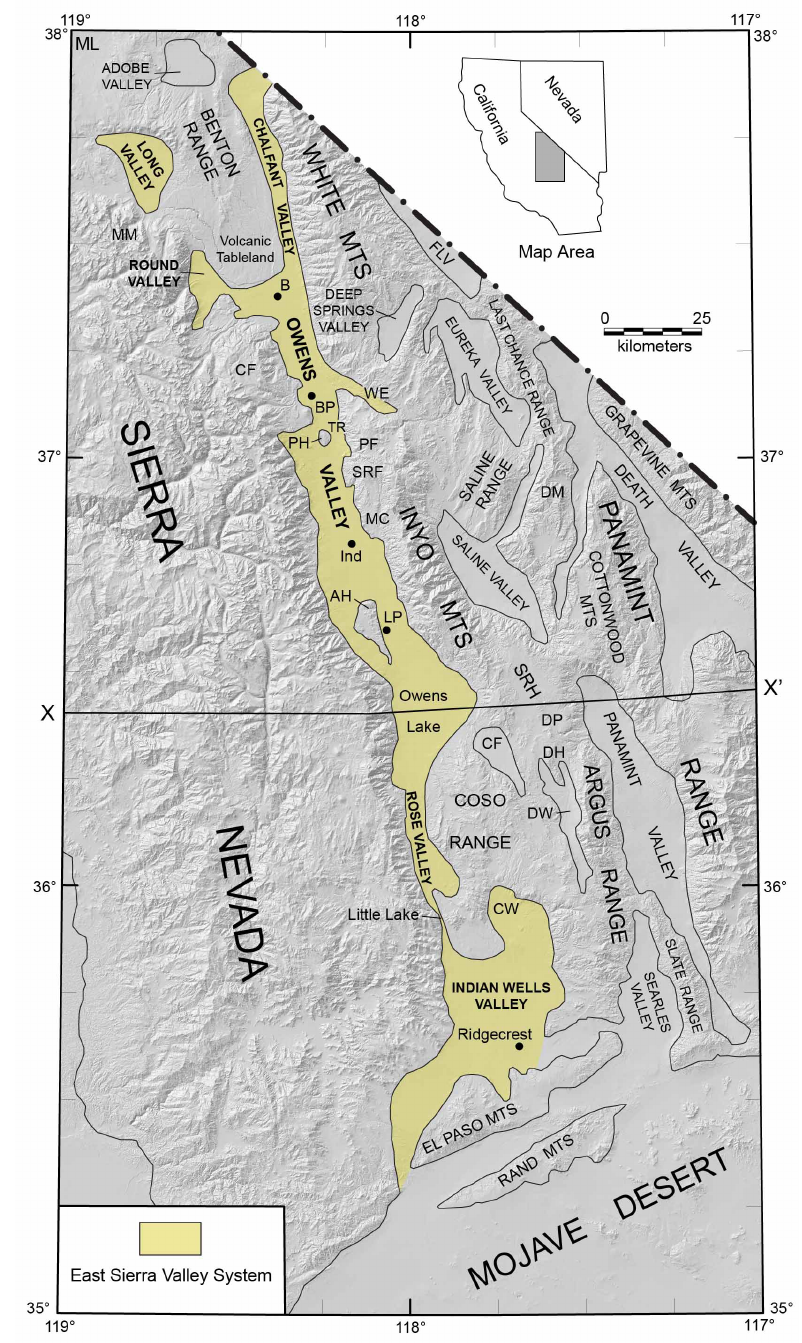
Figure 2. Map showing major geomorphic and cultural features along the western margin of the Basin and Range Province east of the central and southern margins of the Sierra Nevada. AH = Alabama Hills; B = Bishop; BP = Big Pine; CF = Coyote Flat; CW = Coso Wash; DH = Darwin Hills; DM = Dry Mountain; DP = Darwin Plateau; DW = Darwin Wash; FLV = Fish Lake Valley; Ind = Independence; LP = Lone Pine; MC = Mazourka Canyon; ML = Mono Lake; MM = Mount Morrison; PF = Papoose Flat; PH = Poverty Hills; SRF = Santa Rita Flat Pluton; SRH = Santa Rosa Hills; TR = Tinemaha Reservoir; WE = Waucoba Embayment. Cross section X-X' is shown in Figure